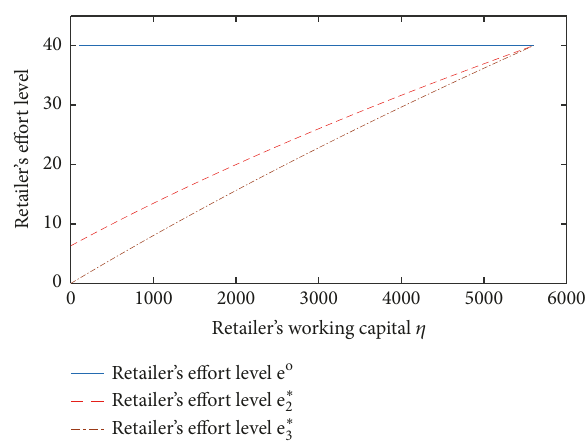
Figure 4: Change trend of retailer’s effort level with retailer’s working capital 𝜂 .